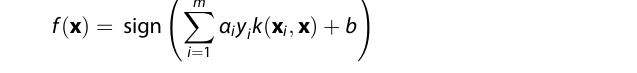
Fig. 2. Each local rotation in the circuit is parameterized by a single element of preprocessed input data so that inner products in the quantum state space correspond to a similarity measure for features in the input space. The number of local rotations are constrained to match the dimensionality of the input data (i.e., 67 parameterized gates for 67-dimensional data), but circuit width and depth may be varied without signi fi cantly impacting the perfor- mance of the classi fi er in a noiseless setting. This circuit structure resembles hardware-ef fi cient, variational circuits used in machine